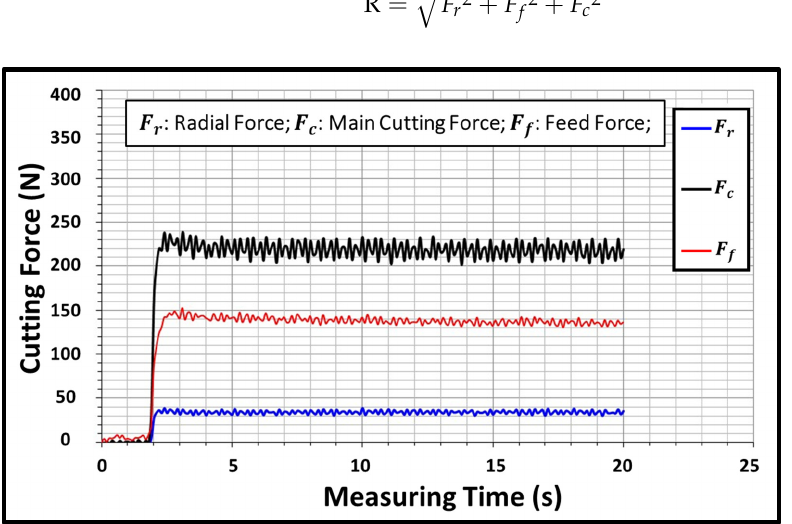
Figure 3. Cutting forces monitoring by Kistler 5070 at v c = 160 m/min, a p = 1 mm, and f r = 0.045 mm/rev.